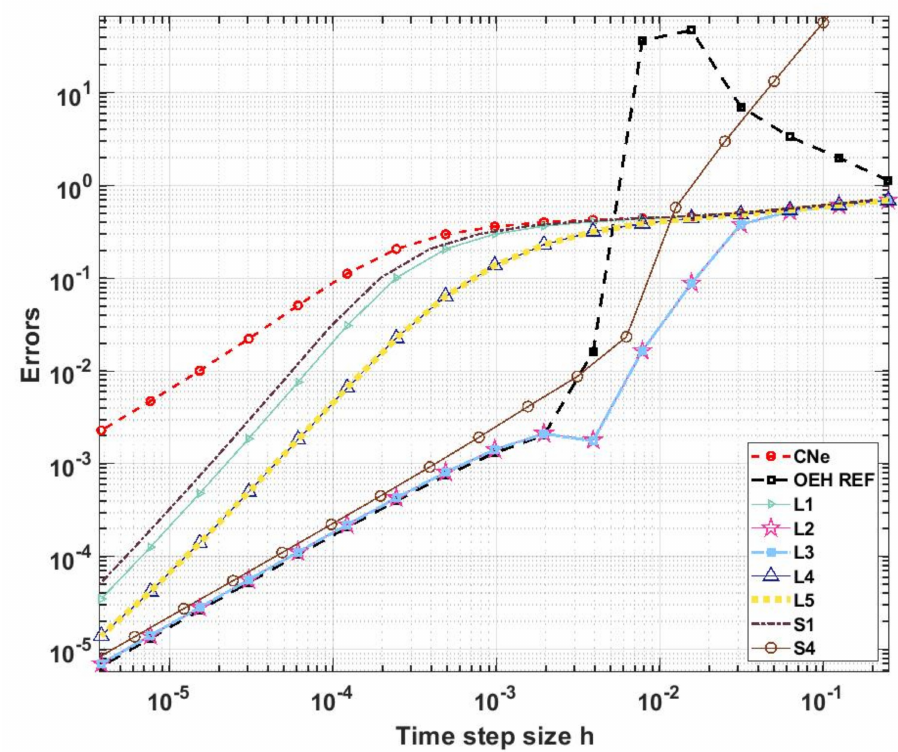
Figure 13. The L ∞ errors as a function of time step size h for the numerical solutions of Fisher’s equation for α = 1 and β =